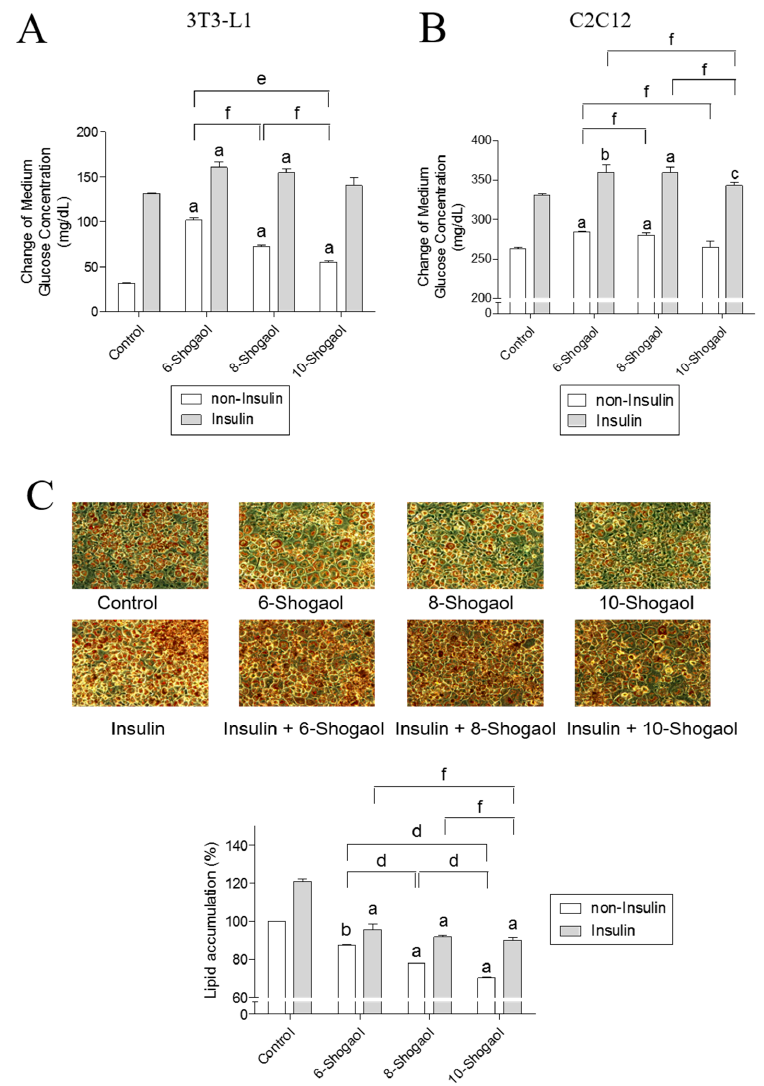
Figure 3. The effect of 6-, 8- or 10-shogaol on glucose utilization and lipid synthesis. Medium glucose consumption in 3T3-L1 adipocytes ( A ) or C2C12 myotubes ( B ) in response to the treatment with 6-, 8- or 10-shogaol. 3T3-L1 adipocytes or C2C12 myotubes were treated with the tested samples with or without insulin treatment (0.32 μ M) in 450 mg/dL D -glucose DMEM. After 24 h, the remaining glucose concentration of the medium was analyzed using a chemistry analyzer. The data represent the amount of glucose in mg/dL consumed by the cells after 24 h of treatment. ( C ) Oil Red O staining and measurement of lipid content (magnification 200×). Data reflect the mean ± SEM of three independent experiments. a p < 0.001, b p < 0.01 and c p < 0.05 indicate a significant difference compared with the control group; d p < 0.001, e p < 0.01 and f p < 0.05 indicate a significant difference between the two compared groups.